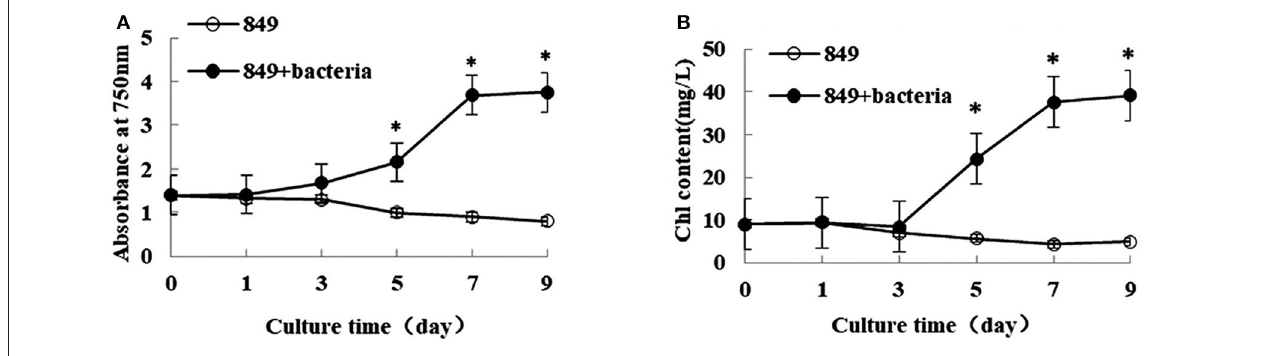
FIGURE 1 | OD 750 (A) and chlorophyll content (B) of algae in the co-culture were measured on days 0, 1, 3, 5, 7, and 9 after incubation in a nitrogen-deprived medium. Pure algae culture was used as the control. Light intensity was 200 µ E · m − 2 · s − 1 and the volume ratio of bacteria (OD 600 = 1.0) and (OD 750 = 1.0) was 1:40. *significant difference between the experimental and control groups. The vertical bars indicate standard errors calculated from at least three independent experiments.